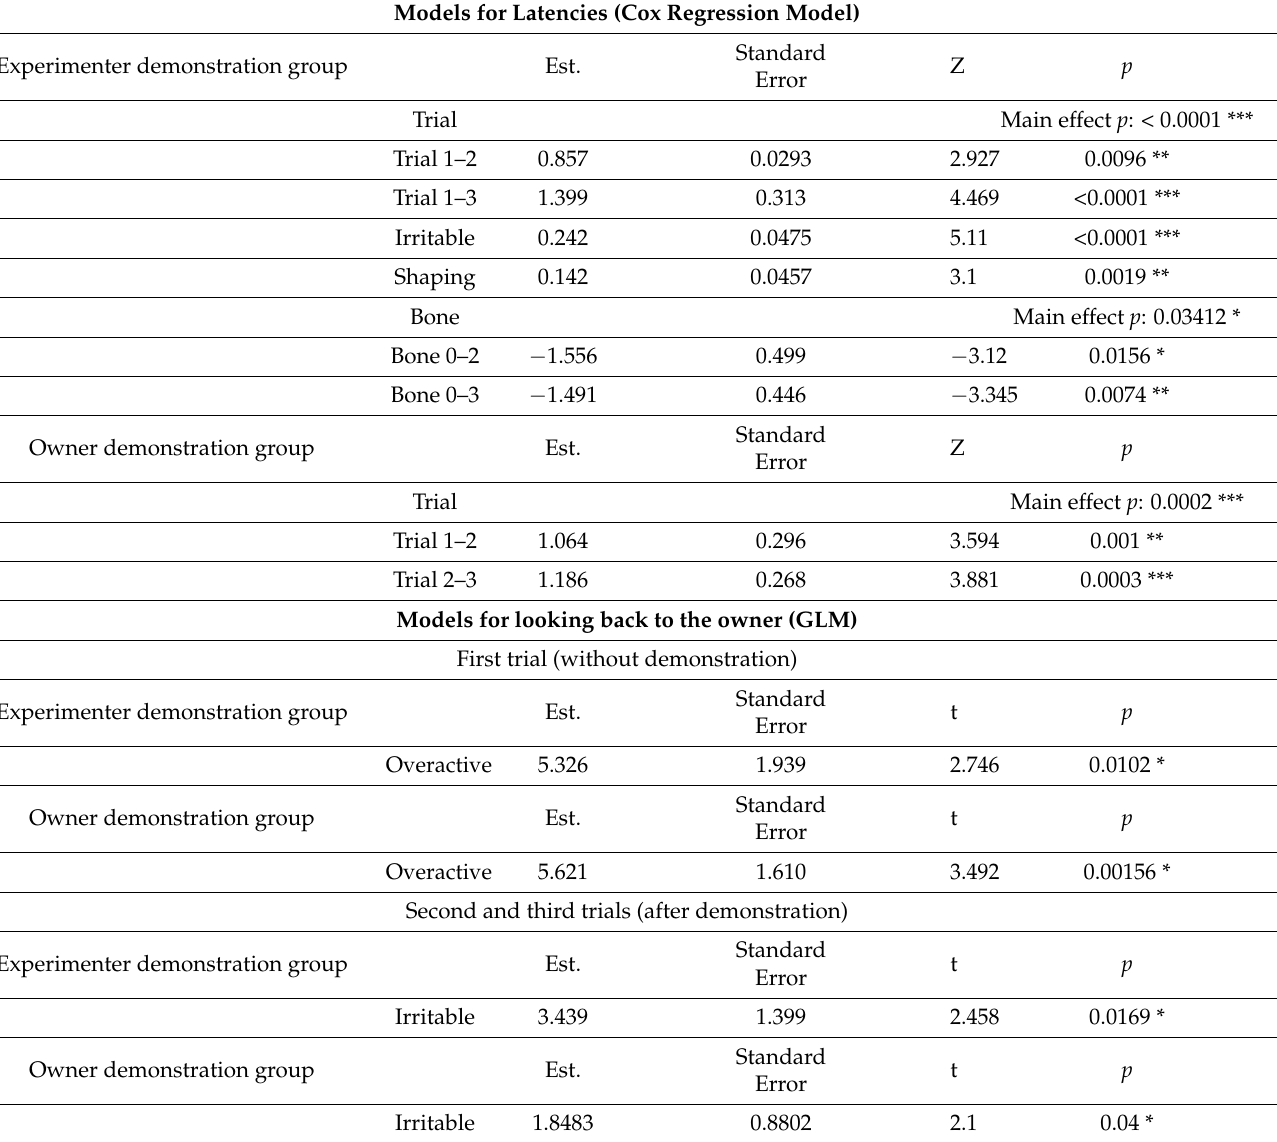
Table 4. The final models as reported in the results. Models for Latencies (Cox Regression